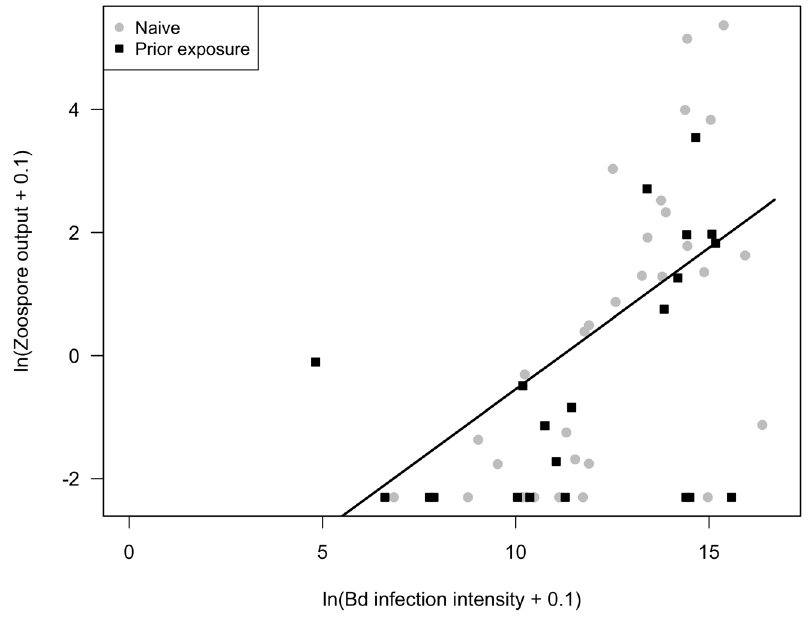
Figure 2. Relationship between Bd infection intensity and zoospore output. The solid black line corresponds to the linear regression fitted to all points ( t 43 =3.926, p , 0.001). Bd infection intensity and zoospore output were positively correlated and not influenced by prior Bd exposure of the amphibian.